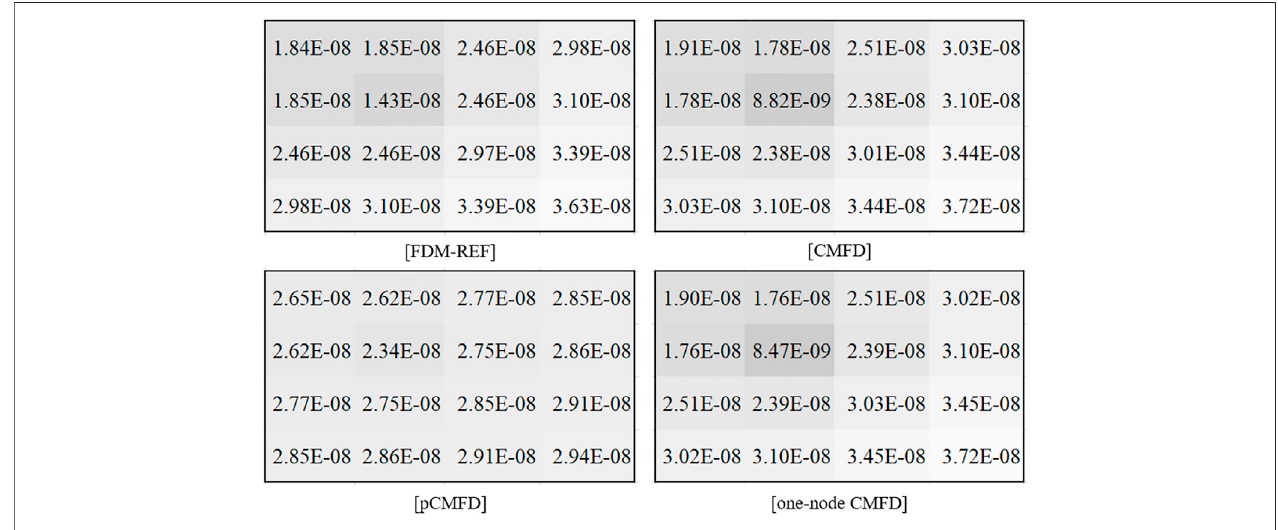
FIGURE 5 | CMFD-based numerical adjoint fl uxes.